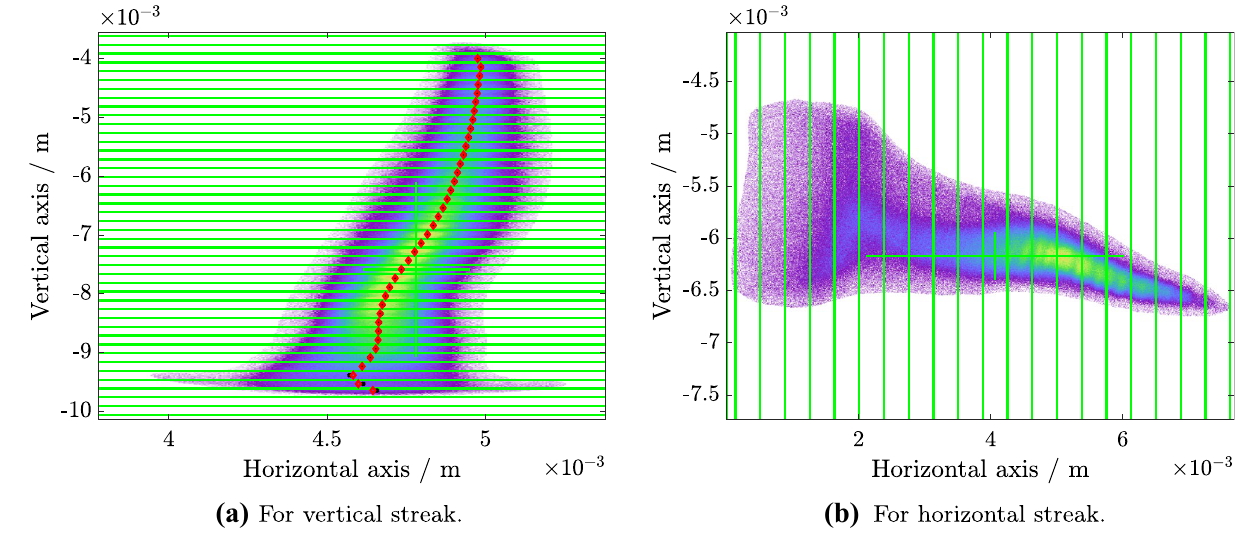
Figure 7. Sample sliced beam images on screen. The beam is streaked in the given direction by the PolariX TDS. For the analysis, the beam is divided into slices (green lines) around the centroid (green cross). The centroid positions within each slice are calculated using the rms method (black stars) and the center of a Gaussian fit (red diamonds).